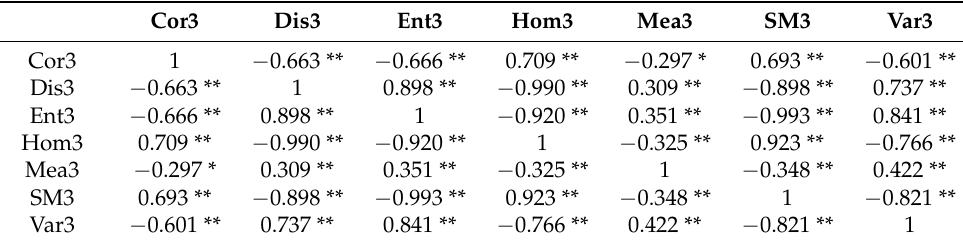
Table 12. Correlation coefficient matrix of texture features in red band.